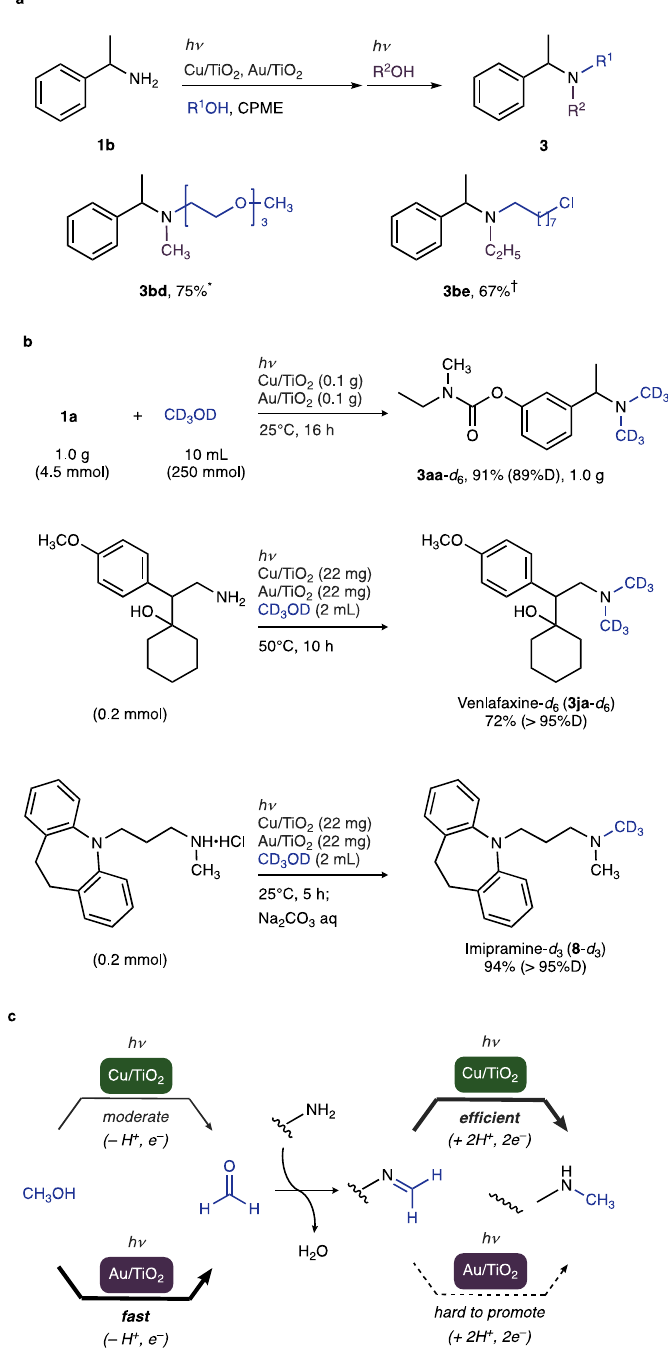
Figure 4. N-Alkylation of Amines by the Cu–Au mixed photocatalytic system. ( a ) Non-symmetrical N,N- dialkylation. Reaction conditions: * 1b (1.0 mmol), Cu/TiO 2 (22 mg), Au/TiO 2 (22 mg), triethylene glycol monomethyl ether (2 equiv), CPME (10 mL), hv , Ar, 50 °C, 13 h; CH 3 OH (5 mL), 50 °C, 6 h. † 1b (1.0 mmol), Cu/ TiO 2 (22 mg), Au/TiO 2 (22 mg), 8-chloro-1-octanol (2 equiv), CPME (10 mL), hv , Ar, 25 °C, 16 h; C 2 H 5 OH (5 mL), 25 °C, 16 h. ( b ) Synthesis of deuterated drugs. ( c ) Synergistic effect in the Cu–Au mixed photocatalytic